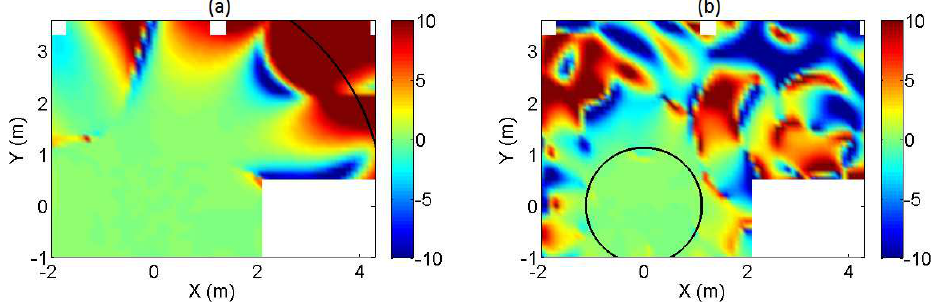
Figure 6. Amplitude error of the reference room at 63 Hz ( a ) and 250 Hz ( b